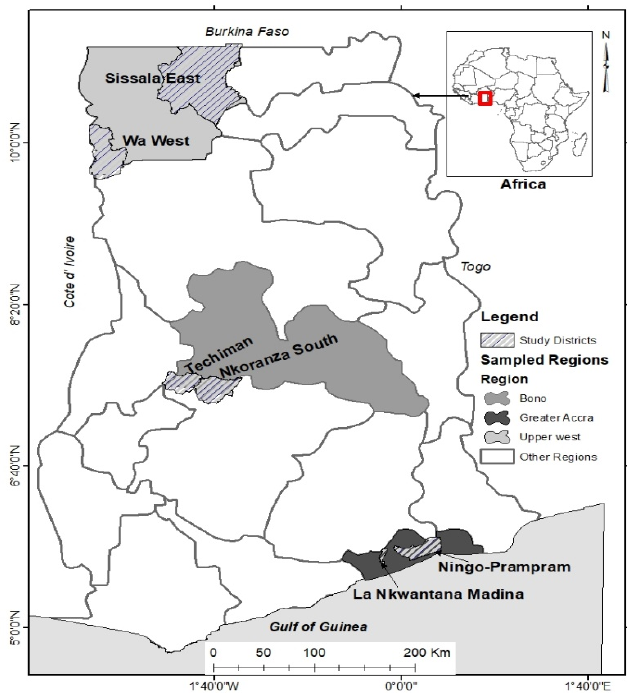
Figure 1. Study sites.